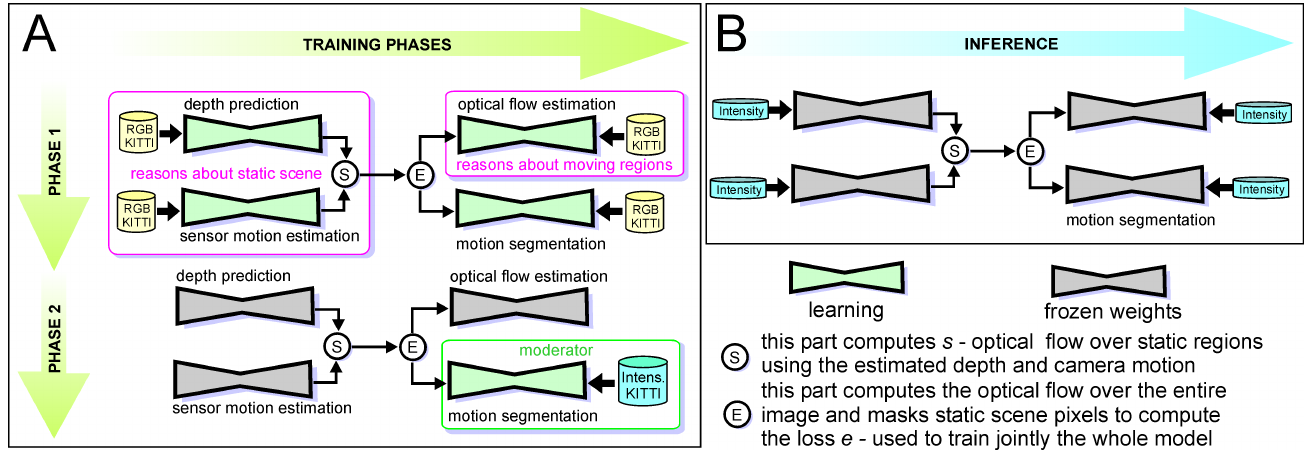
Figure 6. Unsupervised training of the Competitive Collaboration neural network model using the grayscale (Phase 1) and intensity (Phase 2) images ( A ), and the inference process for detection of non-stationary objects using short sequences of intensity images feed to the model ( B